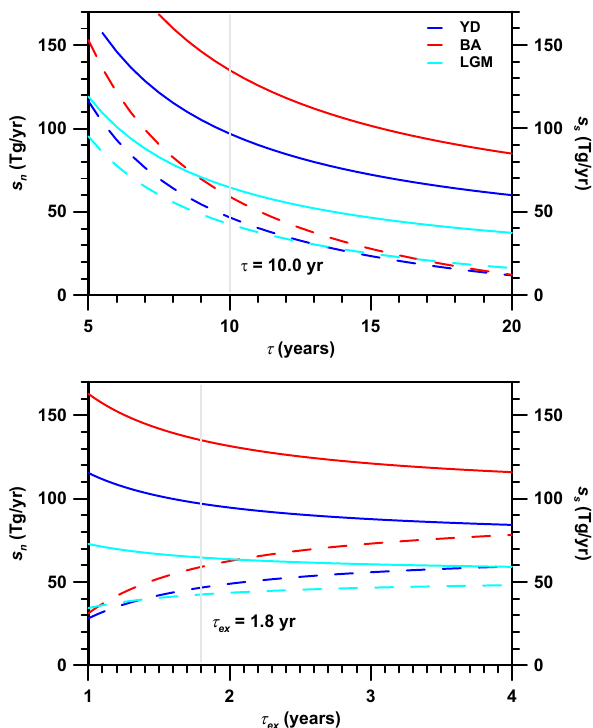
Fig. 6. Sensitivity of CH 4 sources to τ and τ ex . Source distribu- tion (solid lines: s n , dashed lines: s s ) calculated for three different climate states (blue: YD, red: BA, light blue: LGM; concentrations from Table 1) depending on τ (upper panel) and τ ex (lower panel). While one parameter is varied, the other is set to τ = 10 . 0yr or τ ex = 1 . 8yr (grey lines), accordingly. The model is run at these val- ues, which have their origin in the initialisation with a present-day source distribution from Fung et al.